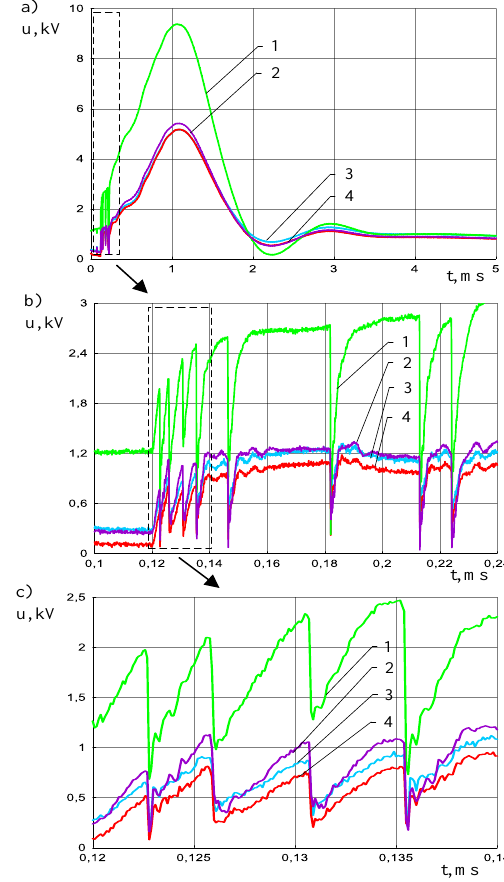
Figure 10. Overvoltage waveforms inside the L3 phase winding when switching off a Tr transformer protected by surge arresters with a vacuum circuit-breaker connected to the transformer by a 2 m long cable line (Figure 3): ( a ) full scale, ( b , c ) different zooms of figure a), 1 — phase voltage waveform on the winding line terminal (x/l = 1.0), 2 — voltage waveform in the middle of the winding (x/l = 0.5), 3 — waveform of the overvoltage in the point with the coordinate x/l = 0.53, 4 — waveform of the overvoltage in the point with the coordinate x/l = 0.47.